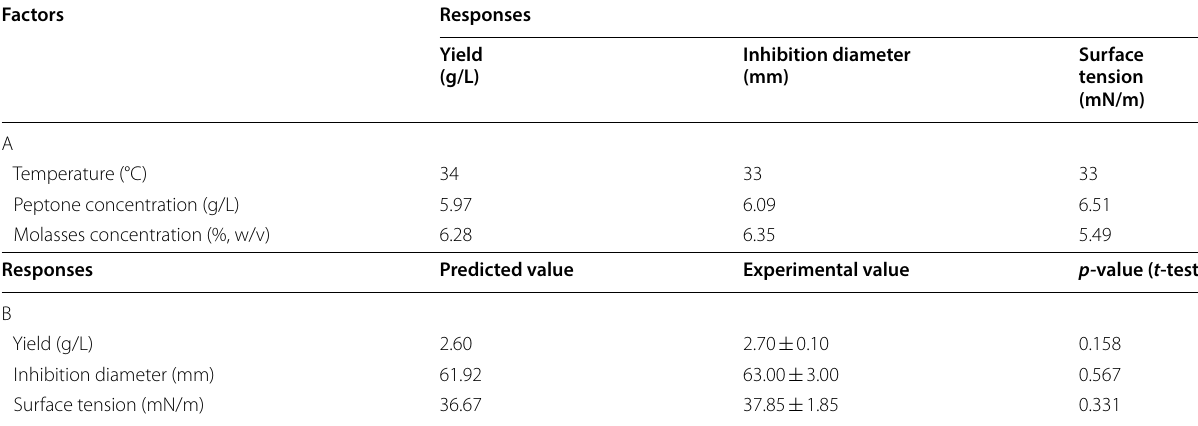
Table 5 Predicted optimum conditions for each response assessed (A) and predicted and experimental values of the responses obtained at the optimum condition defined by multi-response optimization (B) Factors